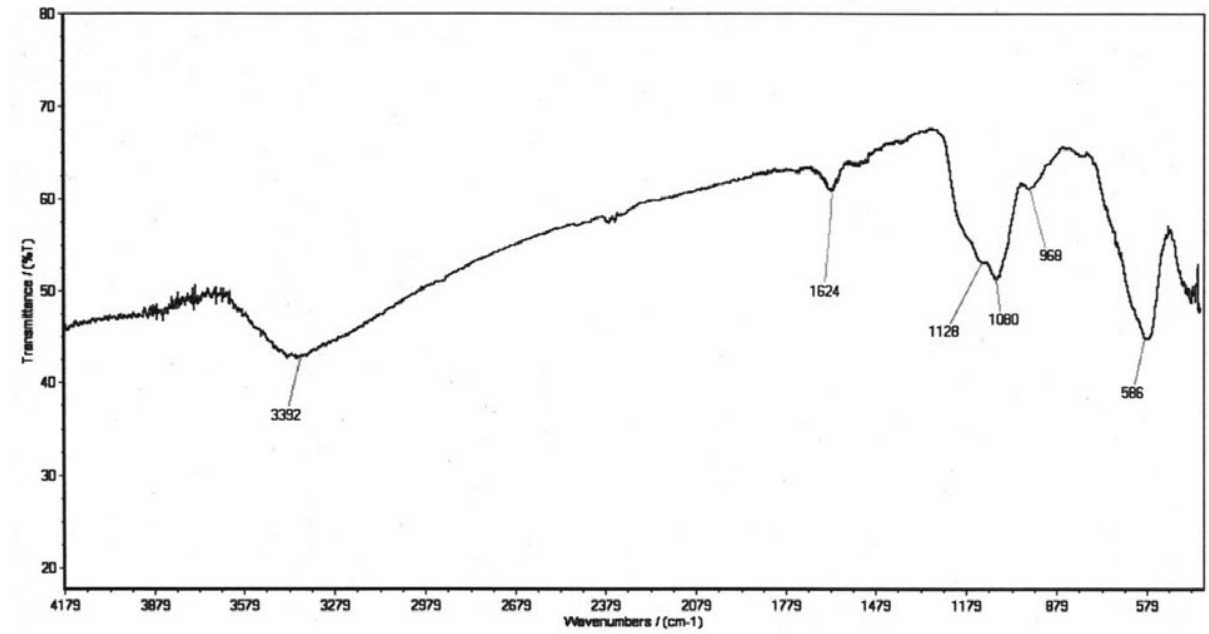
Figure 2 . FT-IR spectrum of Fe